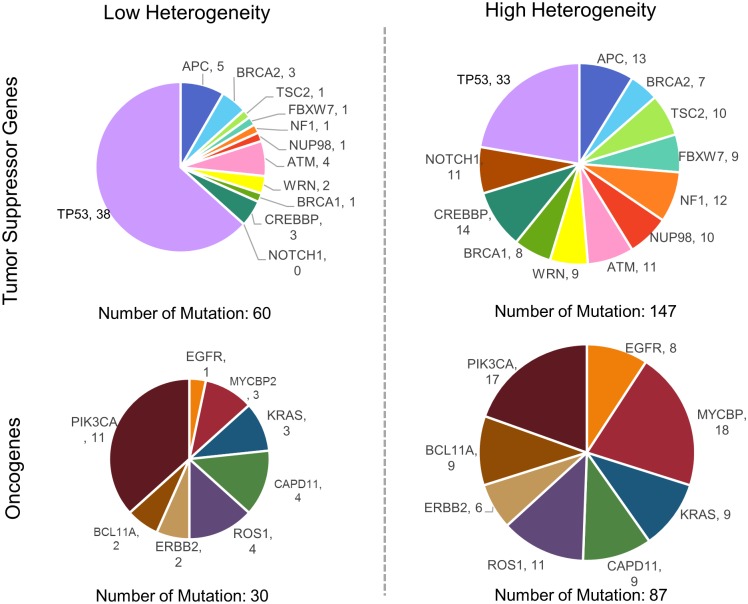
Pie charts representing the frequency of tumor suppressor genes and oncogenes between the low and high heterogeneity groups.Each gene name and its mutation count in a group are displayed.